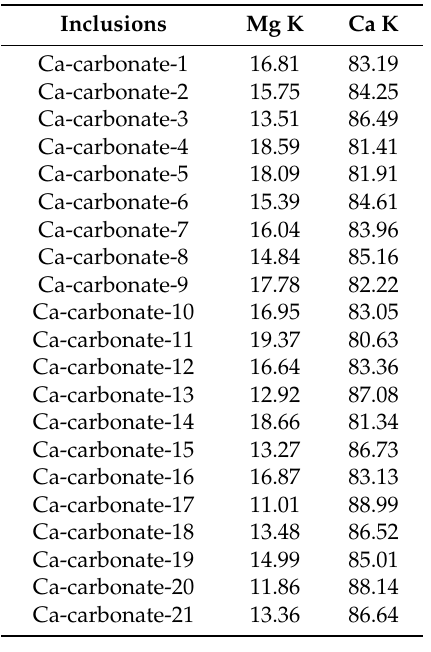
Table A2. Atomic ratios of Mg-Ca within carbonate inclusions formed by Ca . G. lithophora C7 grown in MS-2 medium for two months.